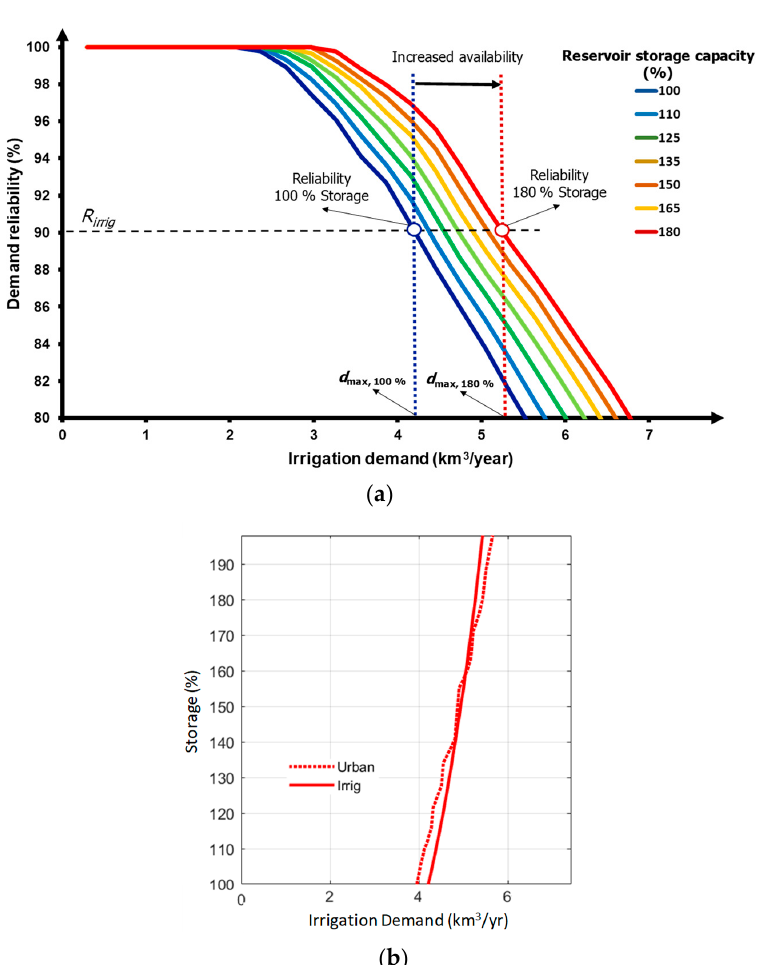
Figure 5. Scheme of the trade-off between demand reduction and another correlative policy measure. ( a ) This represents the demand-reliability curve of the irrigation demand for increasing values of reservoir storage capacities, expressed as a percentage of current values (100%). ( b ) This represents the evolution of water availability for irrigation (required reliability = 90%) and urban (required reliability = 98%) demands.